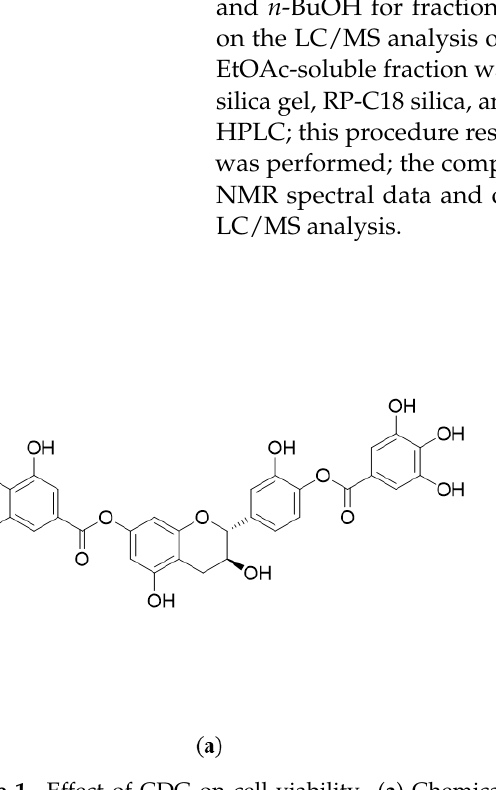
Figure 1. Effect of CDG on cell viability. ( a ) Chemical structure of CDG. ( b ) The immortalized mouse Kupffer cells (ImKCs) cells were treated with CDG (5, 10, 20, 40, and 80 μM) for 24 h. Cell viability rates were compared with the CDG-untreated control group. The cell viability rates are shown via a bar graph. Data are represented as the mean ± standard deviation. ** p < 0.01 relative to the CDG-untreated control group. CDG, catechin- 7,4′ - O -digallate; ImKC, immortalized mouse Kupffer cells.